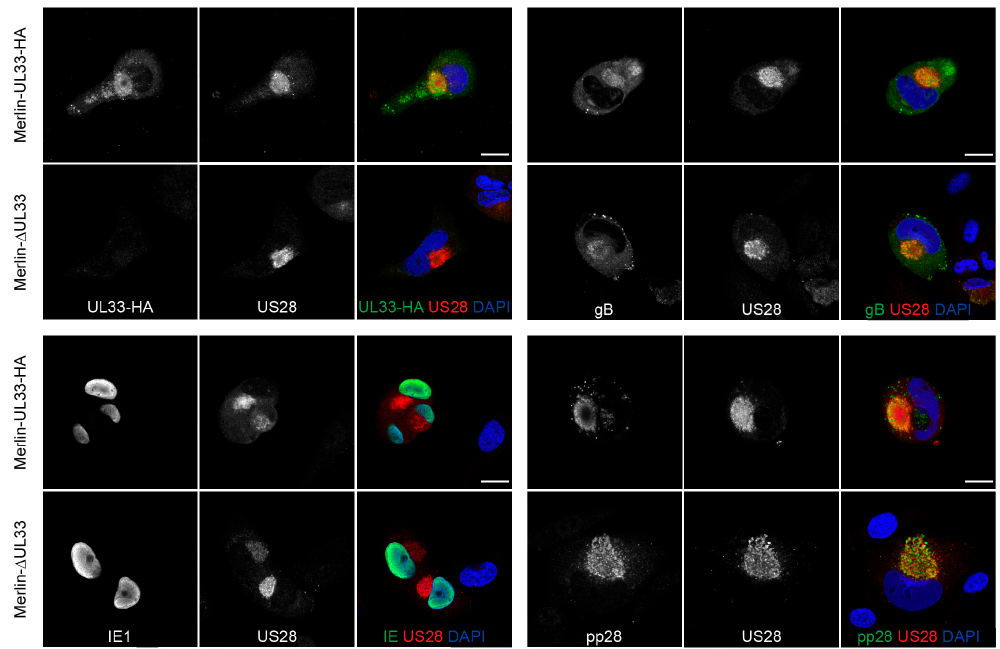
Figure 3. Viral protein expression in HFFF TR cells infected with HCMV-Merlin derivatives: Presence of UL33, US28, IE1, gB, and pp28 at 6 days postinfection of HFFF TR fibroblasts with Merlin-UL33-HA and Merlin- ∆ UL33 virus. Scale bar: 20 µ